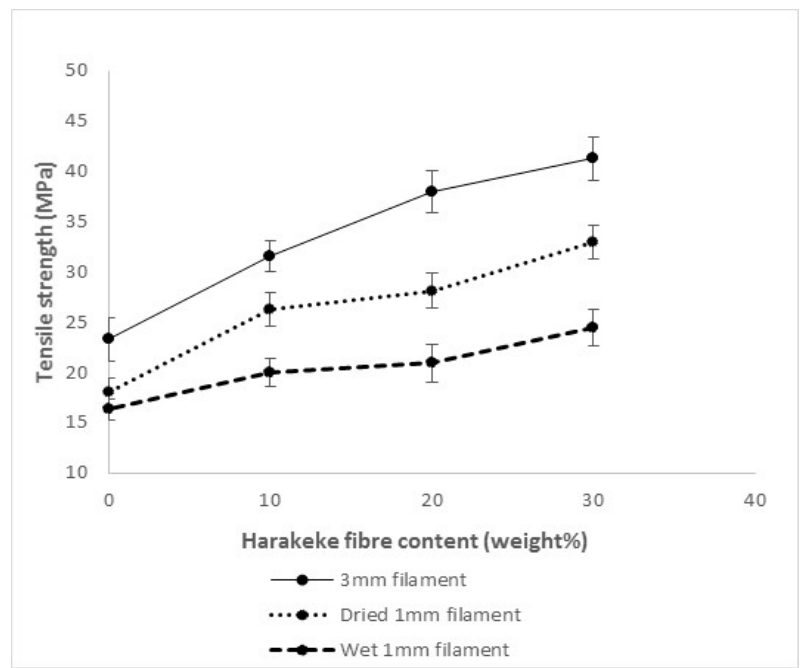
Figure 11. Tensile strength comparison between harakeke reinforced 3 mm, 1 mm wet and 1 mm dry filaments.